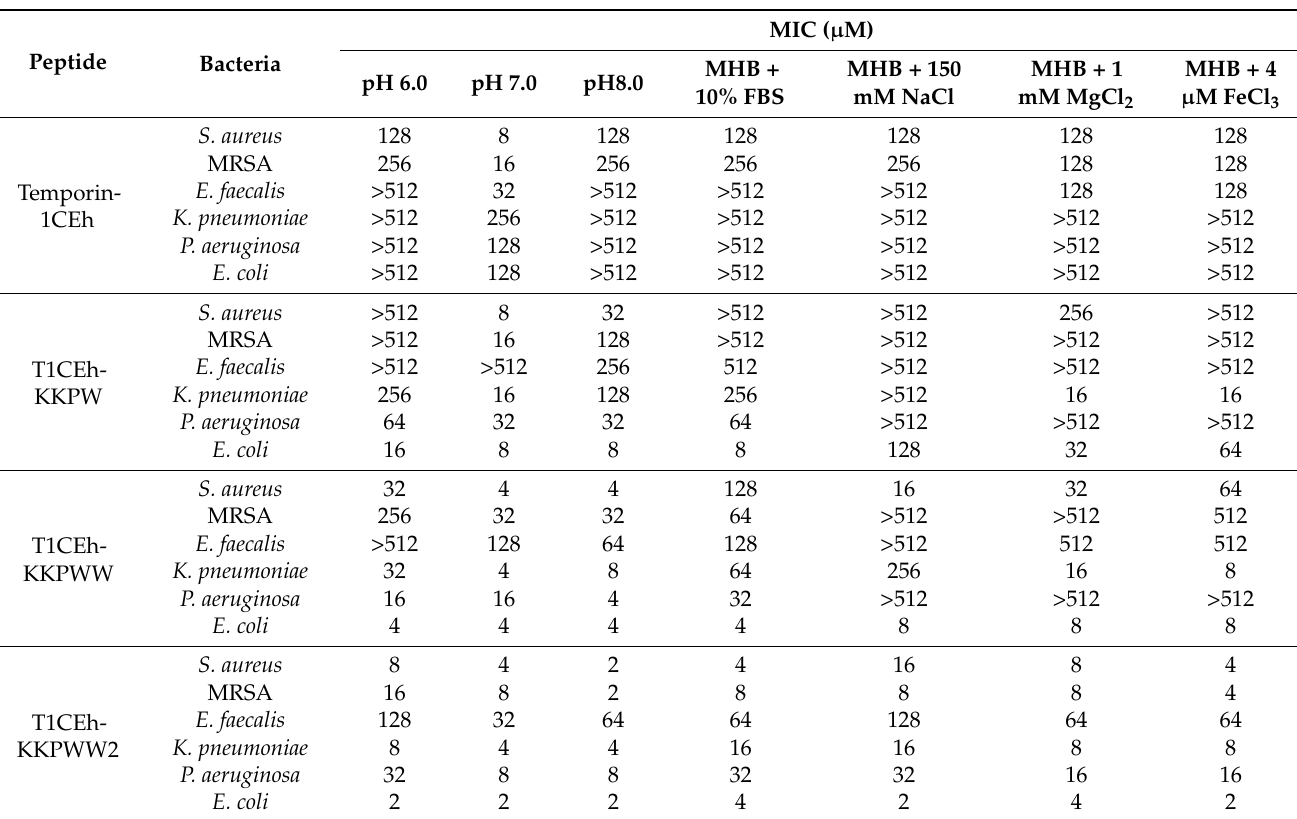
Table 5. MIC values of Temporin-1CEh, T1CEh-KKPW, T1CEh-KKPWW and T1CEh-KKPWW2 against six pathogens at pH 6.0, 7.0 and 8.0 MHB medium environment, as well as the MHB medium respectively contain 10% of FBS, 150 mM of NaCl, 1 mM of MgCl 2 and 4 µ M of FeCl 3 . S.